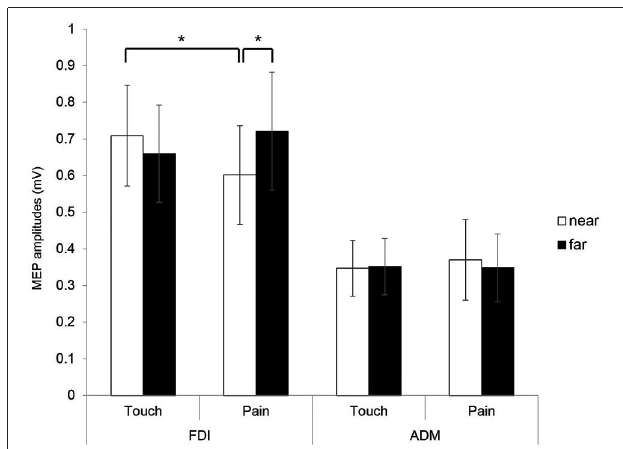
FIGURE 2 | MEPs amplitudes of the FDI and ADM hand muscles in near and far conditions (Error bars: Standard error means (SEM)) .